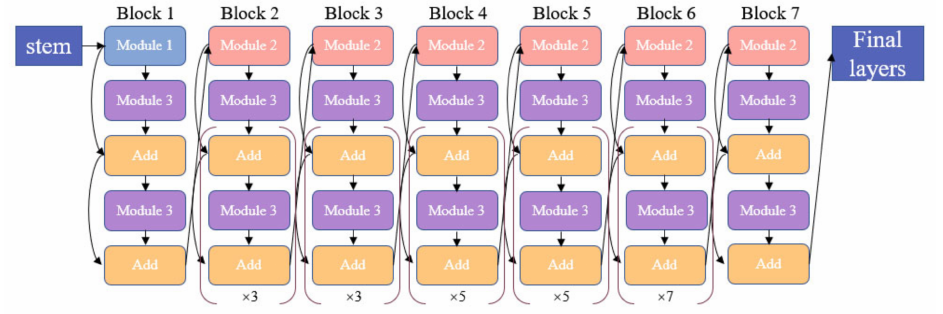
Figure 6. The network structure of EfficientNet-B5.